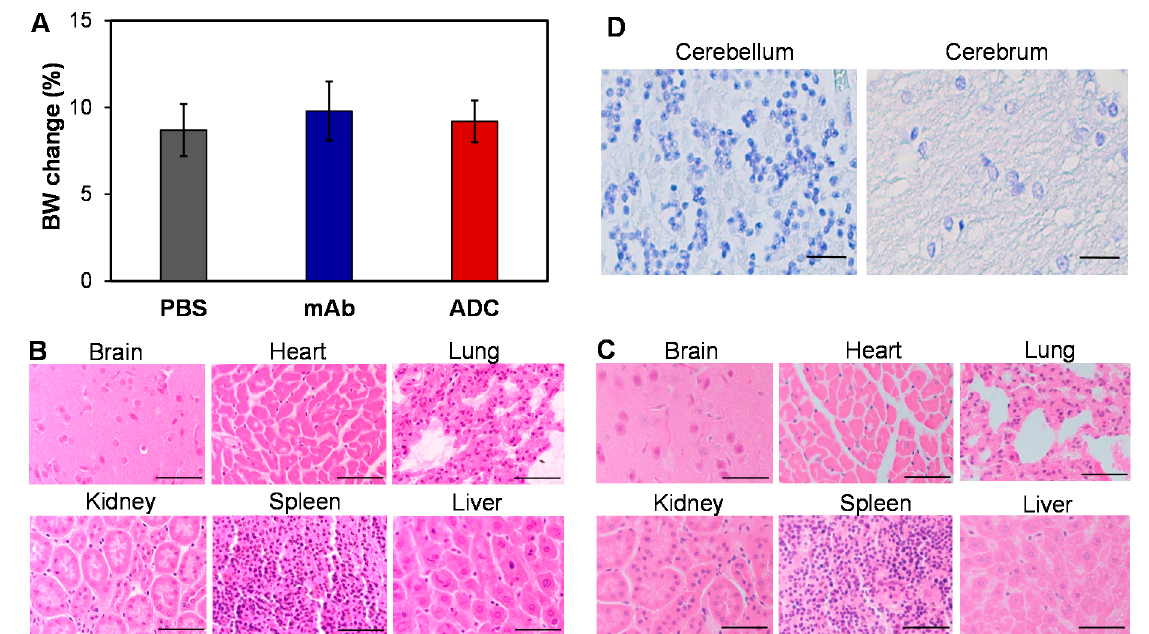
Figure 6. Evaluation of potential toxicity. ( A ) Body weight change of non-meningioma-carrying NSG mice post treatment with PBS, mAb, and ADC. ( B , C ) Evaluation of toxicity by H&E staining of important organs, including brain, heart, lung, kidney, spleen, and liver, in mAb- and ADC-treated groups. Scale bar equals 50 μ m. ( D ) The high-resolution IHC images showed no binding of our anti-SSTR2 mAb to normal brain tissues (cerebellum and cerebrum). Scale bar equals 50 μ m.